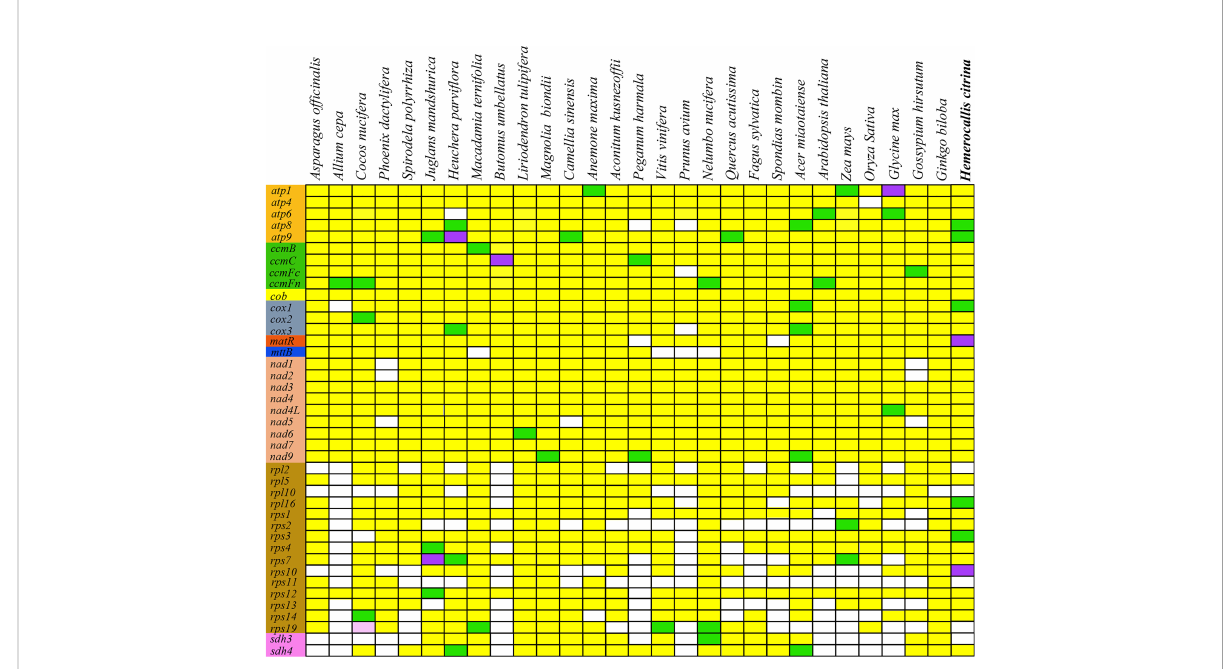
FIGURE 3 Distribution of PCGs in plant mitogenomes. White boxes indicate that the gene is absent in the mitogenome. The remaining colors of boxes indicate that one (yellow), two (green), three (purple), or fi ve (pink) copies exist in the